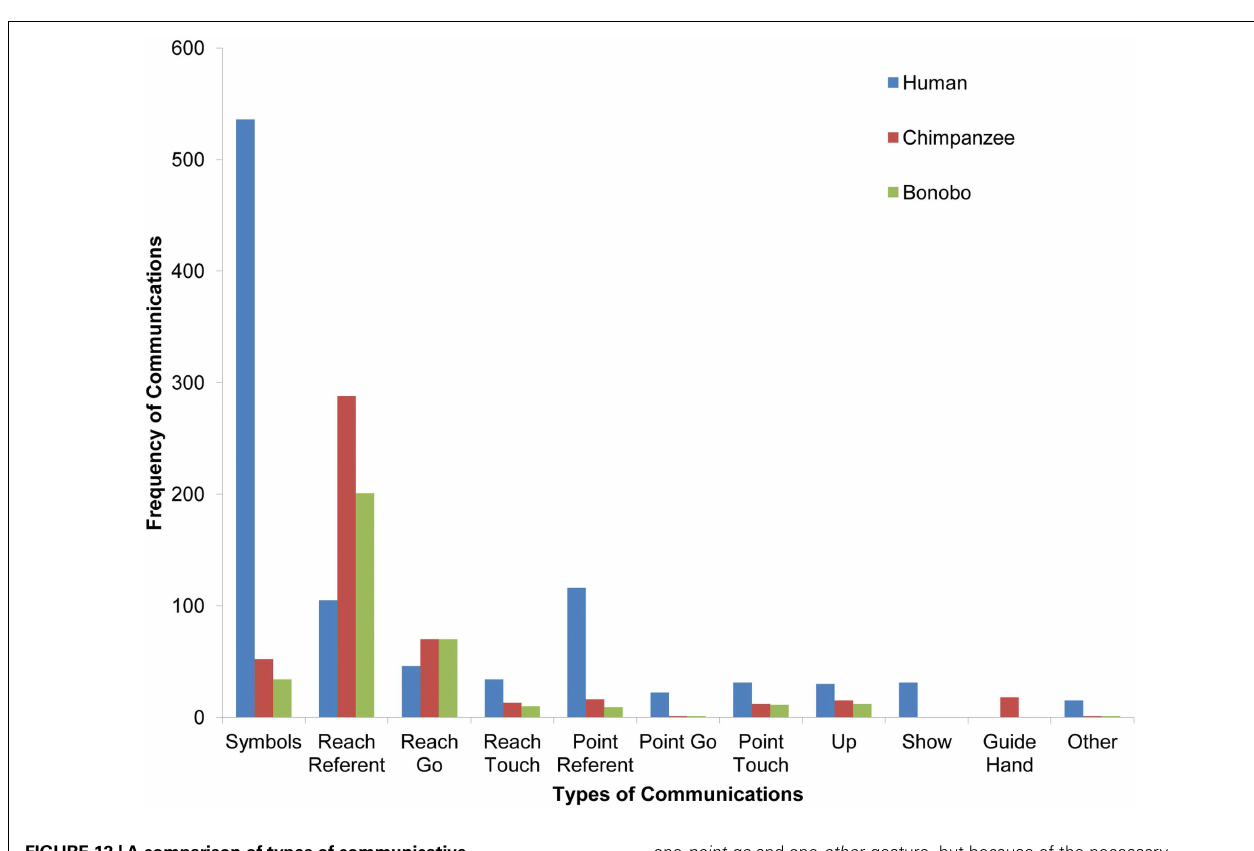
FIGURE 12 |A comparison of types of communicative gestures/symbols across species. Head-point is classified as other due to its infrequency. (The chimpanzee and bonobo each produced